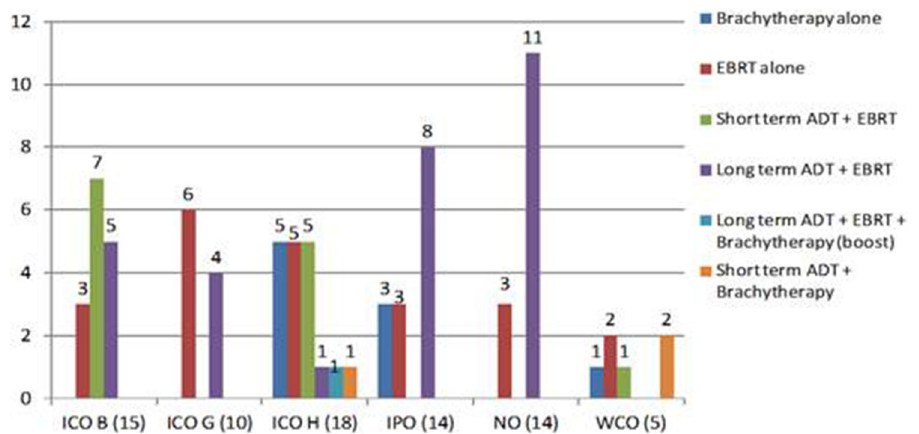
Figure 2. Treatment administered in intermediate-risk patients and number of patients per treatment type.